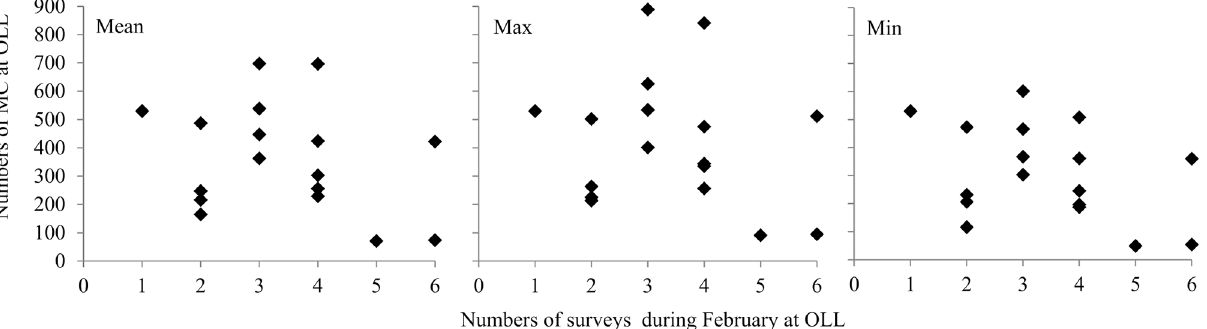
Fig 3. Mother-calf pairs counts vs survey effort at Ojo de Liebre Lagoon. Mean, maximum and minimum counts of mother-calf pairs (MC) at Ojo de Liebre Lagoon (OLL) during the month of February vs the total number of surveys conducted in that month; Mean: sum of the total number of whales counted during all the surveys conducted during February divided by the total number of surveys conducted in that month (total whales/total surveys); Max: survey with the maximum number of MC pairs counted; Min: survey with the minimum number of MC pairs counted.